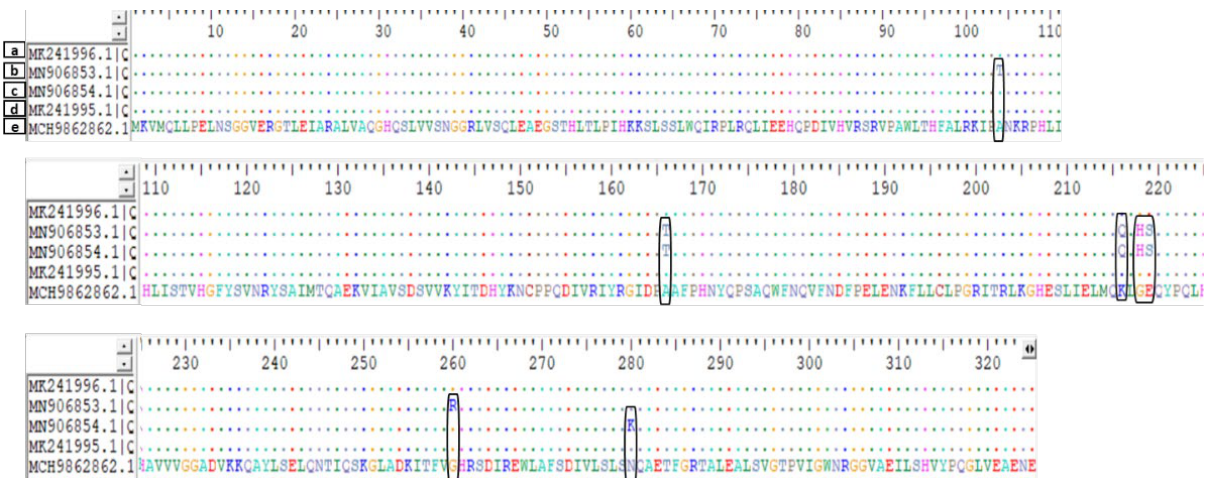
Figure 1. Mutations within lpsB sequence (e) compared with references of 4 sequences (a–d). The lpsB in our isolate is in contig 18 (JAKNTS010000018.1). Sequence (a–d) can be found in NCBI GenBank under their respective number. Mutations within the lpsB gene have been associated with resistance to colistin, with sequences showing any mutations within this gene most likely to be resistant to colistin.